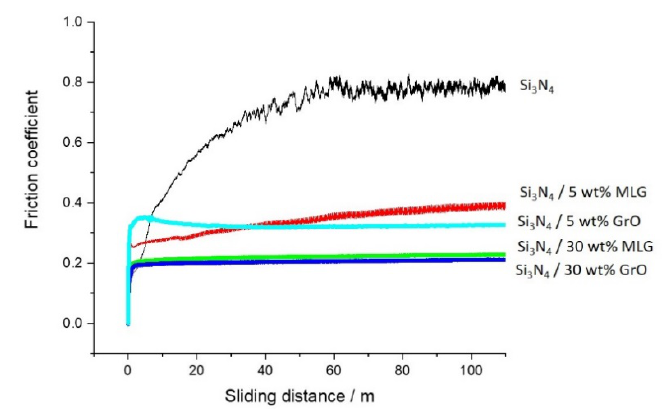
Figure 9. Friction coefficient measurement of Si 3 N 4 -based composites.